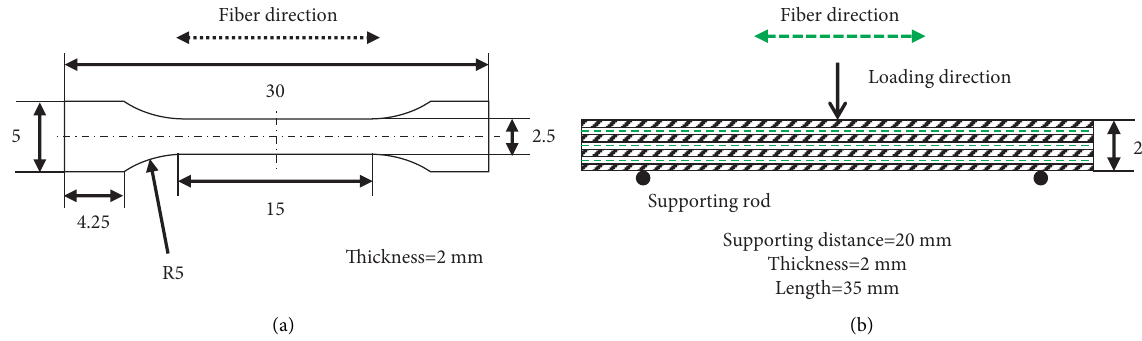
Figure 3: Dimensional drawing of the sample in mechanical properties testing: (a) size of the tensile sample and (b) size of the three-point bending sample.